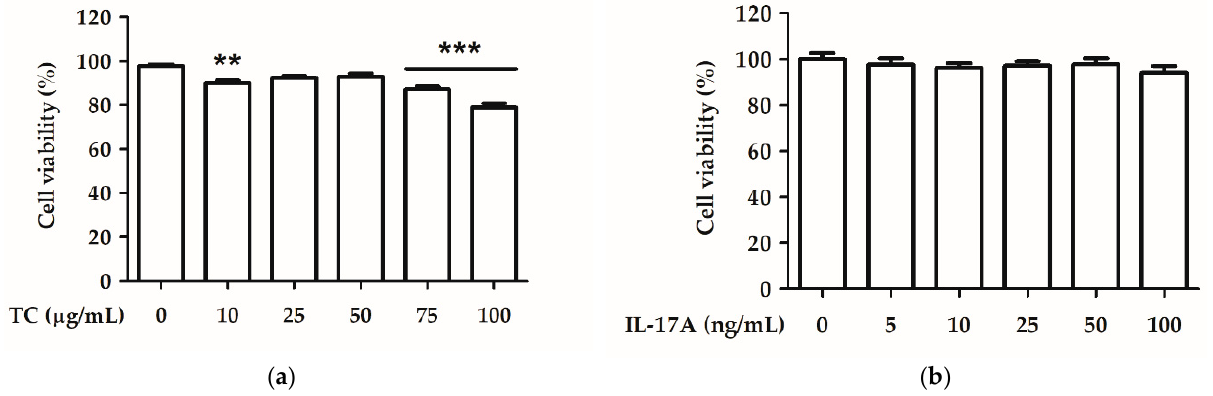
Figure 5. Effect of ( a ) TC and ( b ) IL-17A on cell viability in human keratinocytes. Significant differences between treated groups were evaluated. ** p < 0.01; *** p < 0.001 compared to the control group.